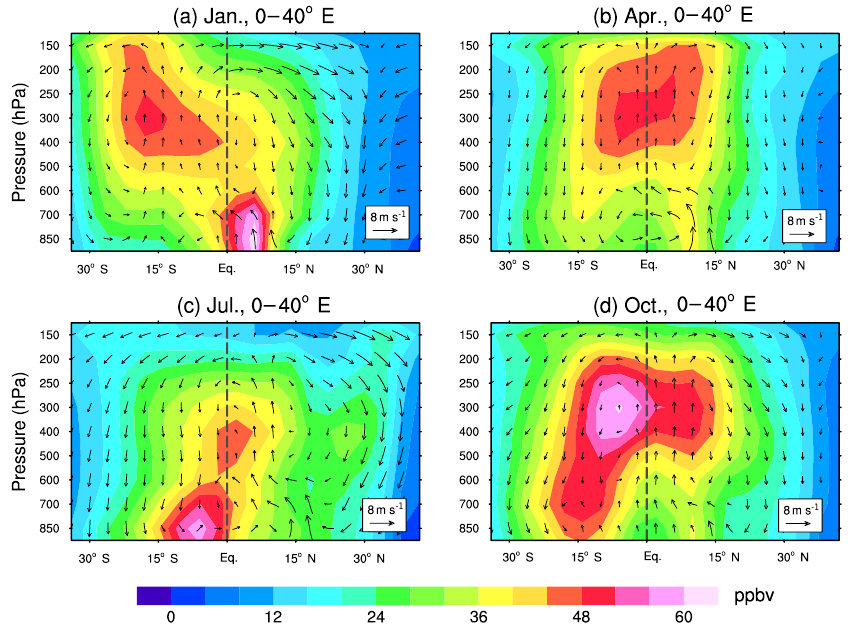
Figure 11. Latitude–altitude distribution of African ozone (in ppbv, in color), overlaid with winds (shown by arrows), in (a) January, (b) April, (c) July, and (d) October. The ozone values are the means over 0–40 ◦ E (see Fig. 10) from the 20-year GEOS-Chem simulation. The vertical velocities in the p coordinates are enlarged by 200 times for illustration purposes. The vertical dashed line indicates the equator.